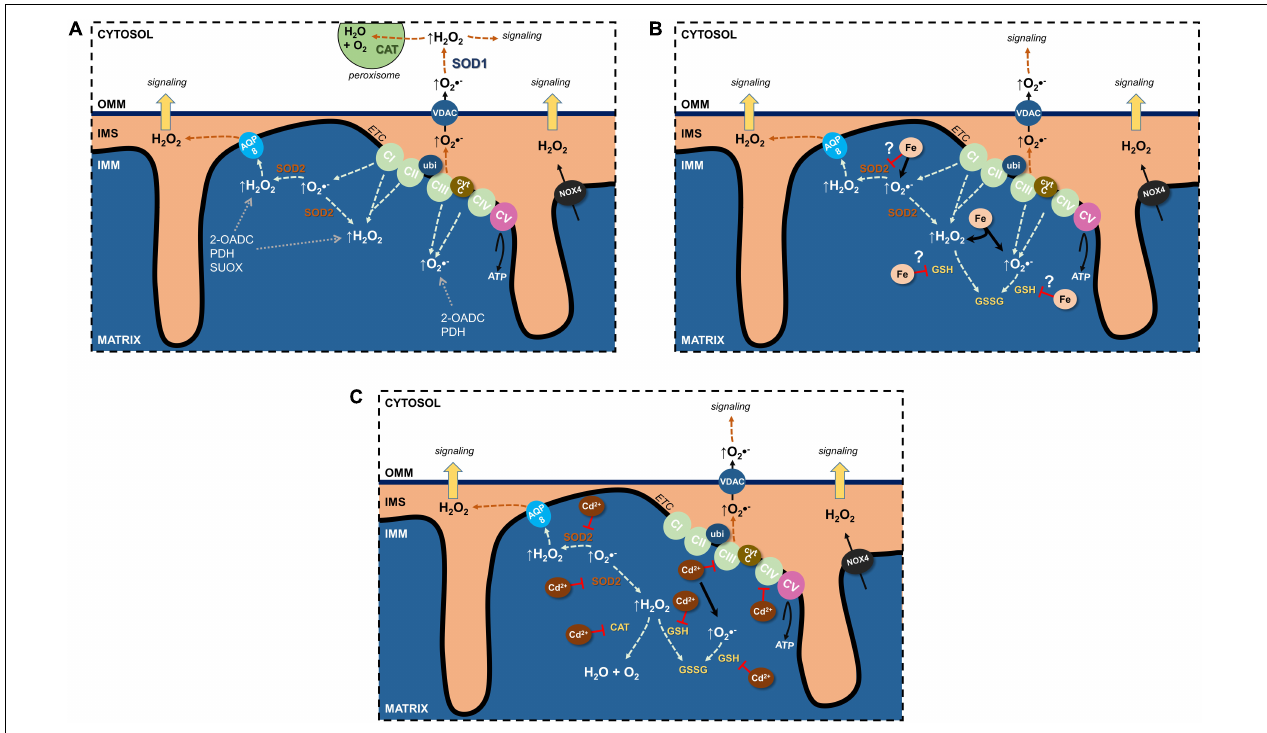
FIGURE 1 | Effects of Fe and Cd on mitochondrial reactive oxygen species (ROS). (A) Sources of physiological ROS from mitochondria and their release into the cytosol. (B) Fe increase mitochondrial ROS formation and potentially inhibits antioxidants. (C) Cd inhibits the electron transport chain, binds GSH as well as decreases antioxidant enzyme activity to augment mitochondrial ROS generation. See text for further details. 2-OADC, 2-oxoacid dehydrogenase complexes; AQP, aquaporin; CAT, catalase; cytc, cytochrome c; ETC, electron transport chain; GSH, glutathione; IMS, intermembrane space; NOX4, NADPH oxidase 4; PDH, pyruvate dehydrogenase; SOD, superoxide dismutase; SUOX, sulfite oxidase; ubi, ubiquinone; VDAC, voltage-dependent anion